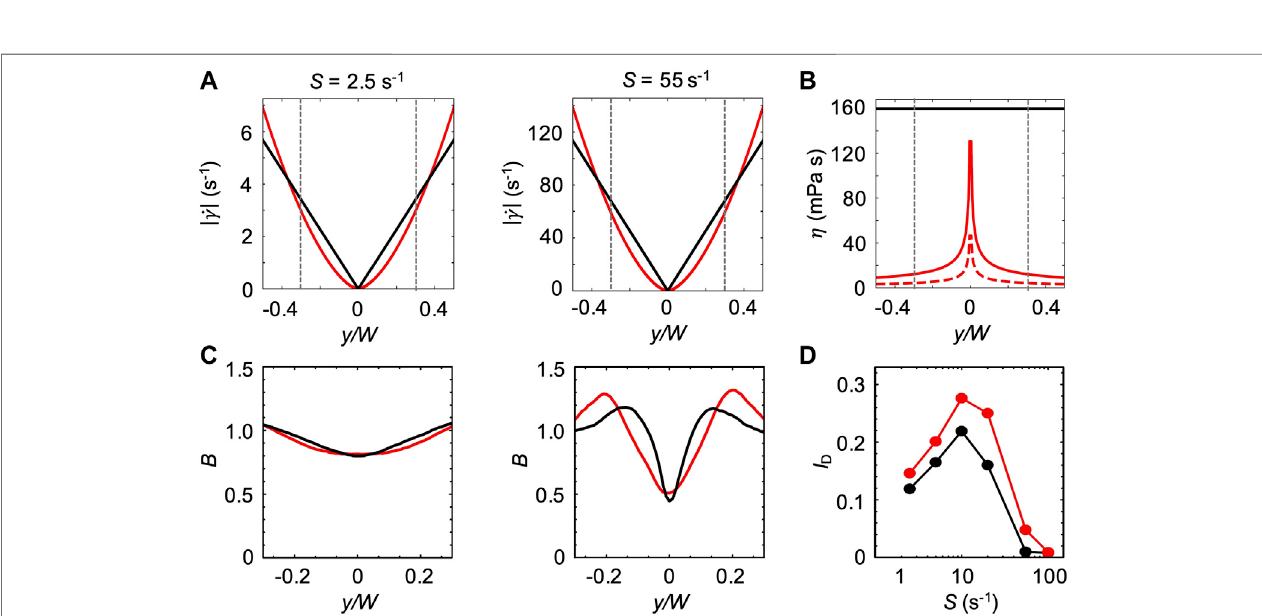
FIGURE 7 | (A) Absolute values of the shear rate | _ γ | in the channel in a Newtonian (black) and non-Newtonian (red) fl uid at mean shear rates S = 2.5 s − 1 (left panel) and S = 55 s − 1 (right panel). The Newtonian pro fi les were calculated as S = -8 yU / W 2 . The non-Newtonian pro fi les were calculated with CFD simulations modeling the rheological behavior of xanthan gum 0.1 w/v%, as described in the Materials and Methods. (B) No- fl ow ambient viscosity η 0 of xanthan gum 0.1 w/v% (solid black line) and ambient viscosity pro fi les calculated withCFD simulations for S = 2.5s − 1 (solid red line)and S = 55 s − 1 (dashedred line). (C) Concentration pro fi les B obtained from the mathematical model with the Newtonian (black) and non-Newtonian (red) shear rate pro fi les reported in panel A at mean shear rates S = 2.5 s − 1 (left panel) and S = 55 s − 1 (right panel). The numerical concentration pro fi les were obtained by modeling bacterial transport in a straight 50 cm-long channel, with bacterial swimming velocity V = V 0.1% . (D) The depletion index I D as a function of the mean shear rate S , measured from the numerical bacterial concentration calculated in the conditions described in (C)